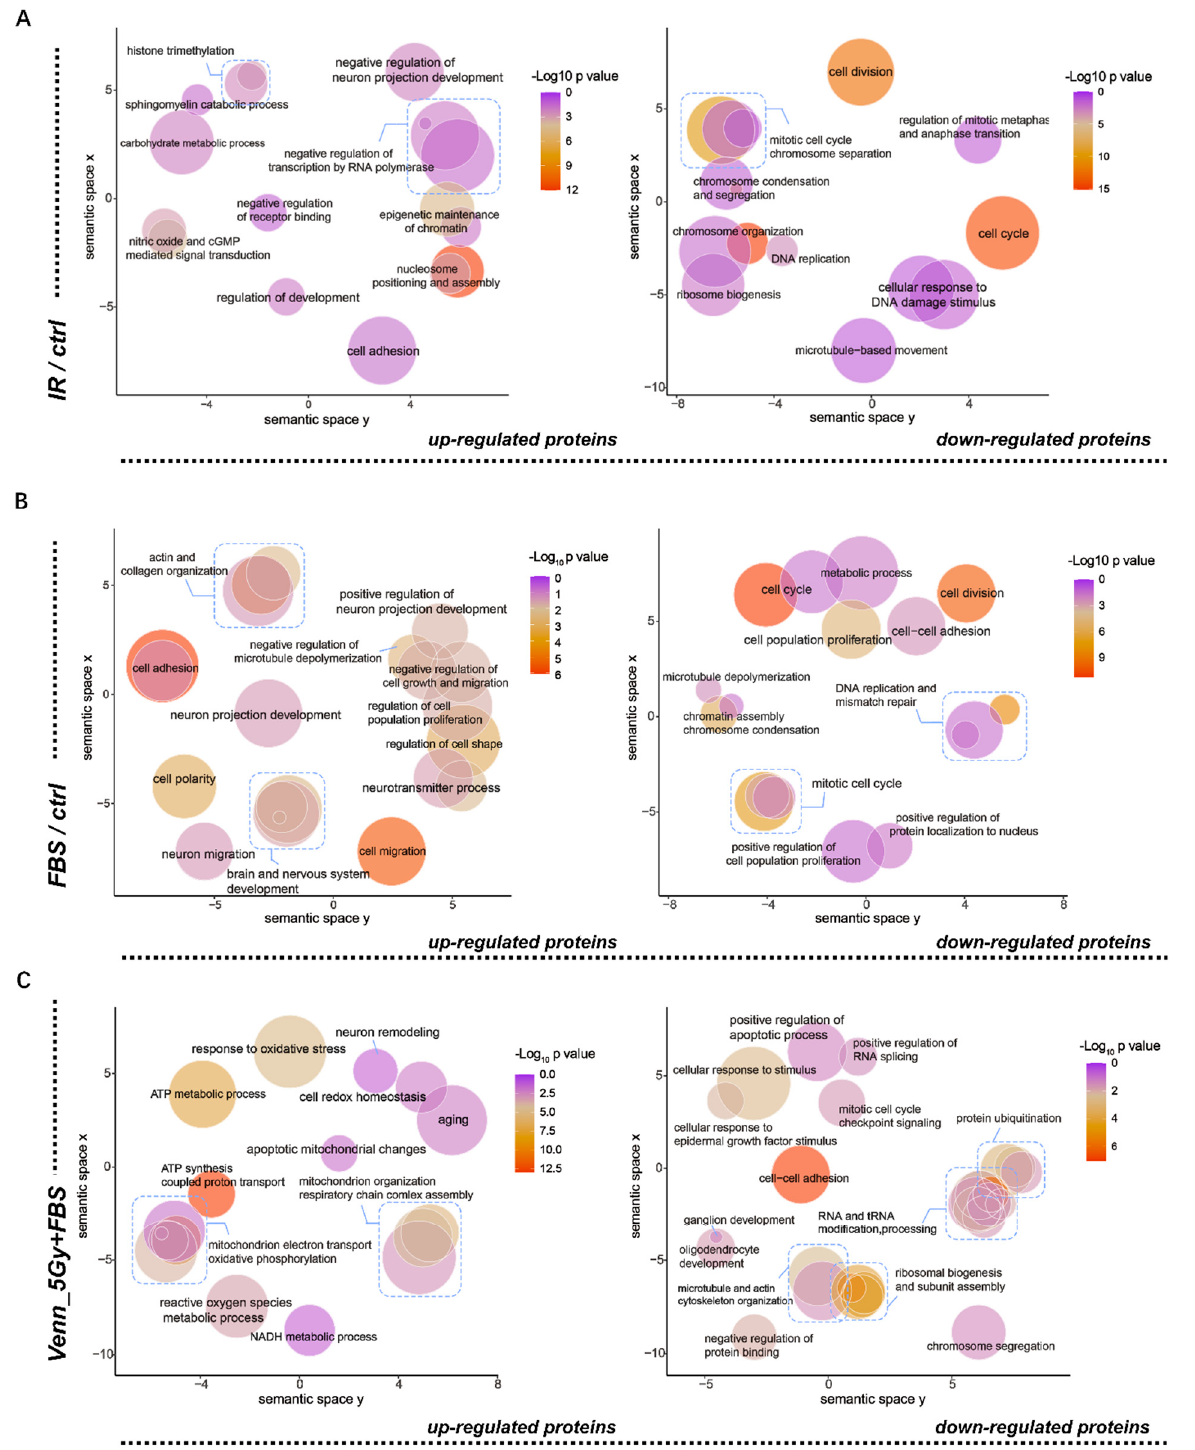
Figure 2. Gene ontology (GO) enrichment analysis and visualization of differentially expressed proteins. ( A – C ) The scatter plots show the significantly enriched GO terms for DEPs in different groups, ( A ) IR vs. ctrl group, ( B ) FBS vs. ctrl group, and ( C ) 5Gy+FBS vs. FBS group.